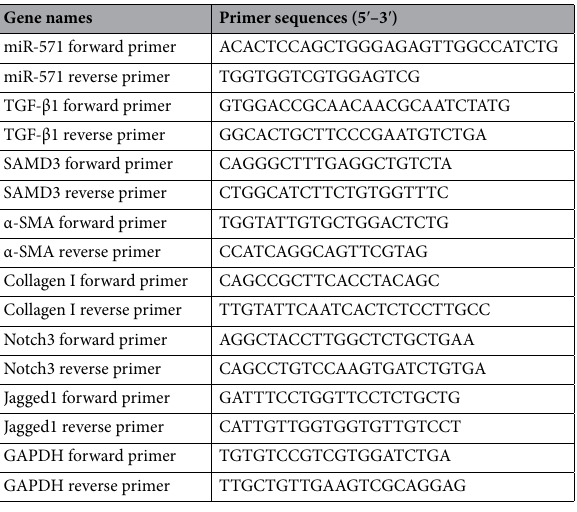
Table 2. RT-PCR primer